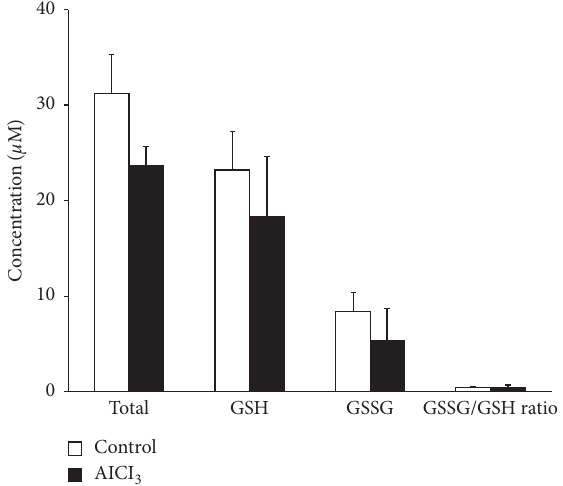
Figure 7: The effects of AlCl 3 on erythrocyte glutathione level. Total glutathione, reduced glutathione (GSH), and oxidized glu- tathione (GSSG) were determined in erythrocytes following 24hours’ exposure to AlCl 3 (100 µ M). No significant differences were found between the control and AlCl 3 -treated